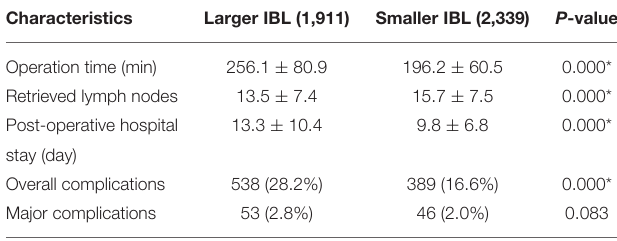
TABLE 3 | Outcomes between larger IBL group and smaller IBL group.